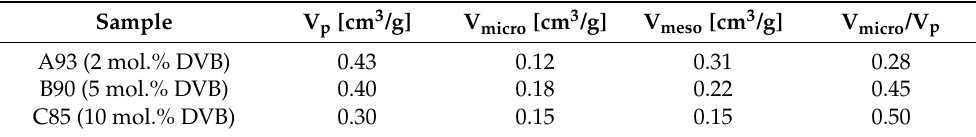
Table 3. Comparison of micro- and meso-porosity created by hypercrosslinking.